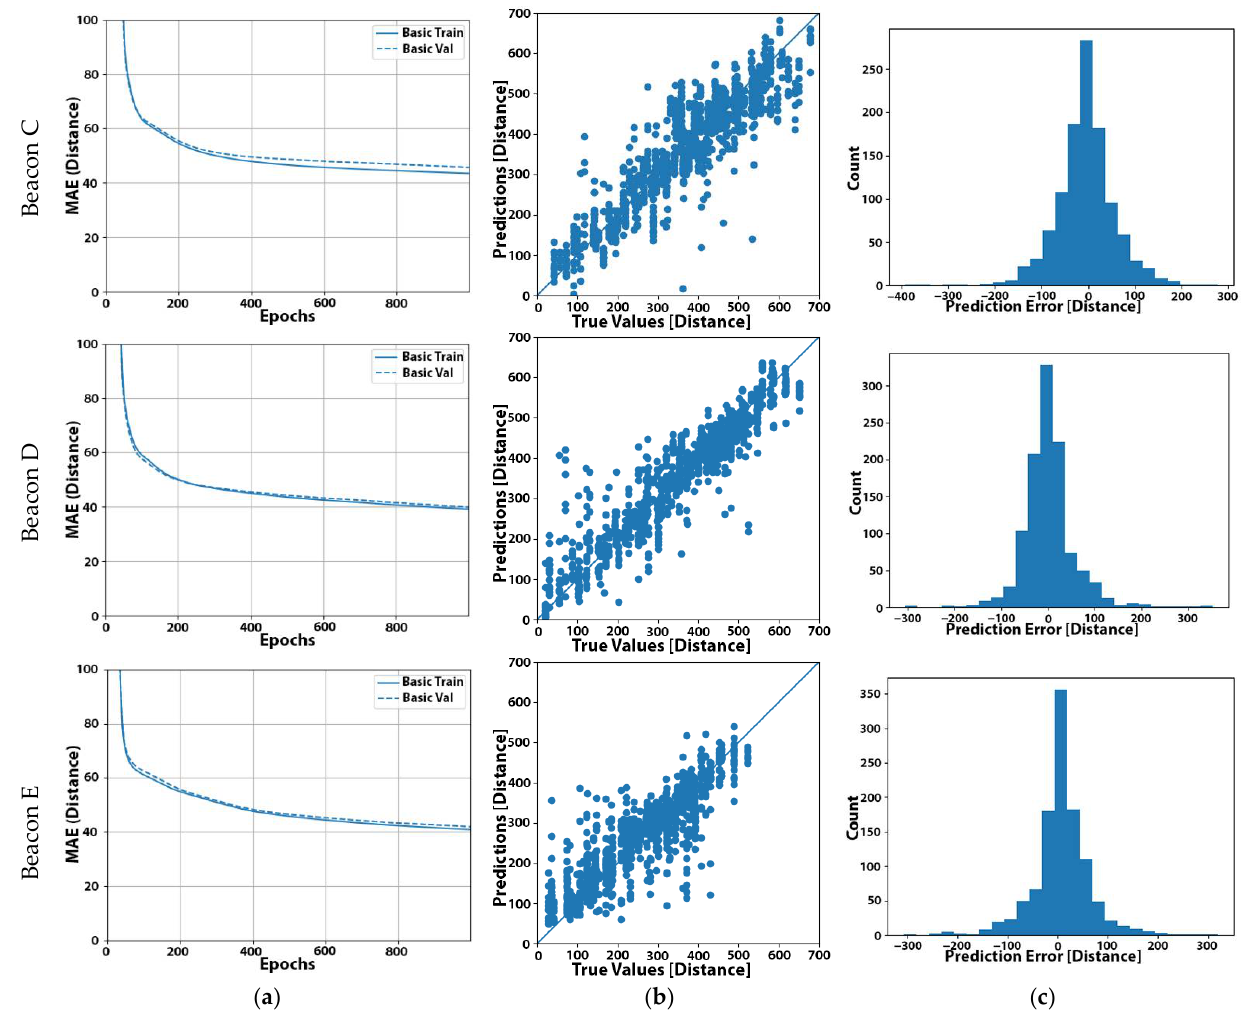
Figure 2. Experiment No. 1 results: ( a ) learning curve for our baseline model; ( b ) plot of the predicted distance (in cm) from our basic model against the actual distance of the user for the set of 1111 measurements; ( c ) distribution of the prediction error (in cm) using our basic model (distances expressed (in cm) in ( a – c )).